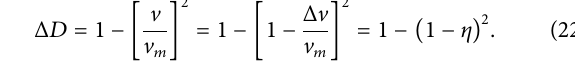
Frontiers in Earth Science |